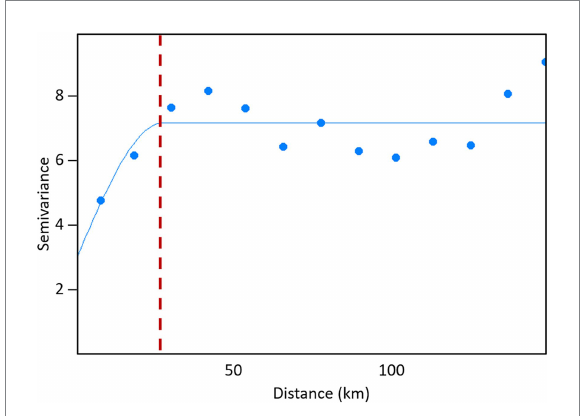
FIGURE 5 Variogram of generalized linear model residuals (points), with spherical variogram model (solid blue line) and spatial correlation range (red dashed line) for sampled rates of V. destructor mites in managed honey bee colonies in Southern Ontario (2015–2019).